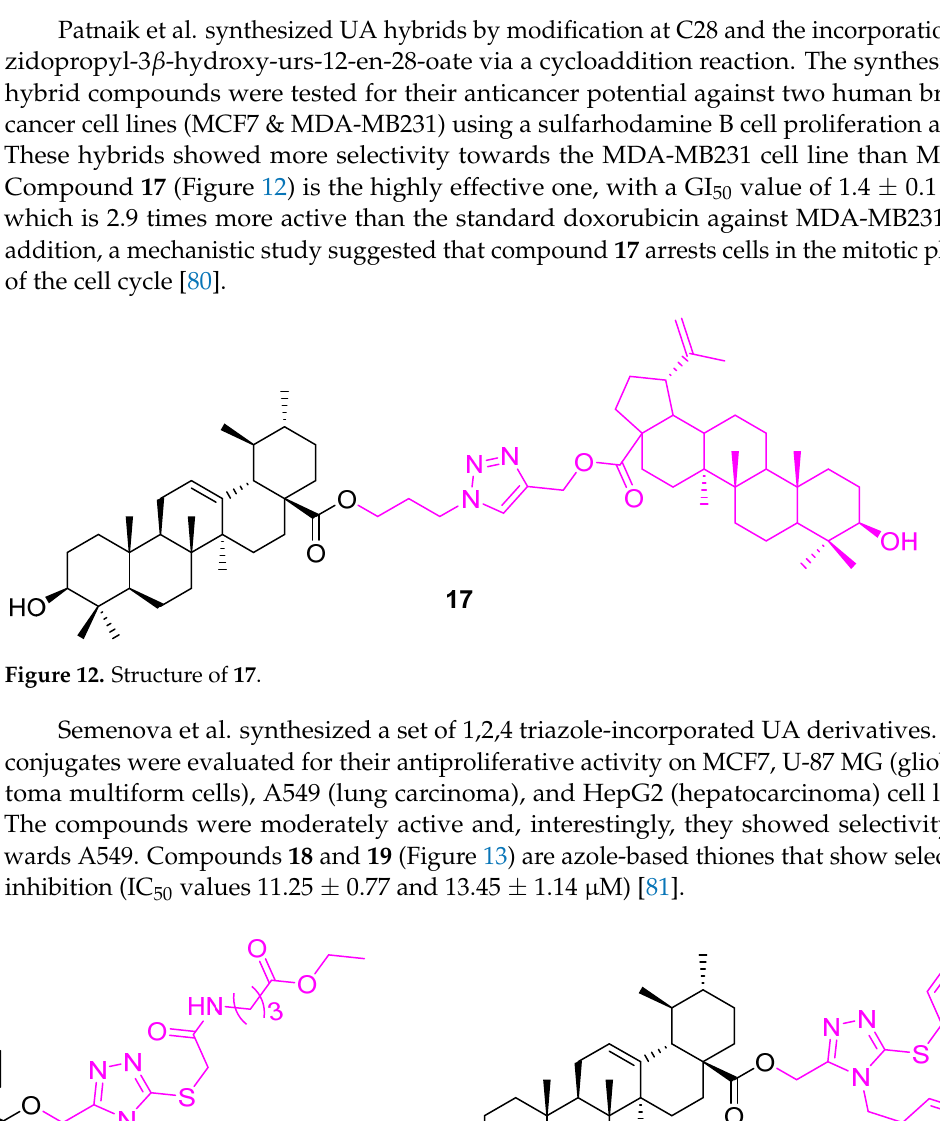
Figure 11. Structure of 16 .